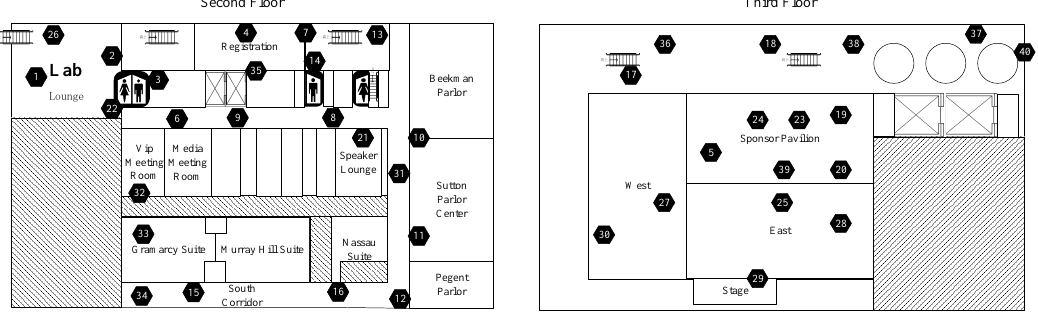
Figure 4. The venue of sensors deployment from Data-Sensing